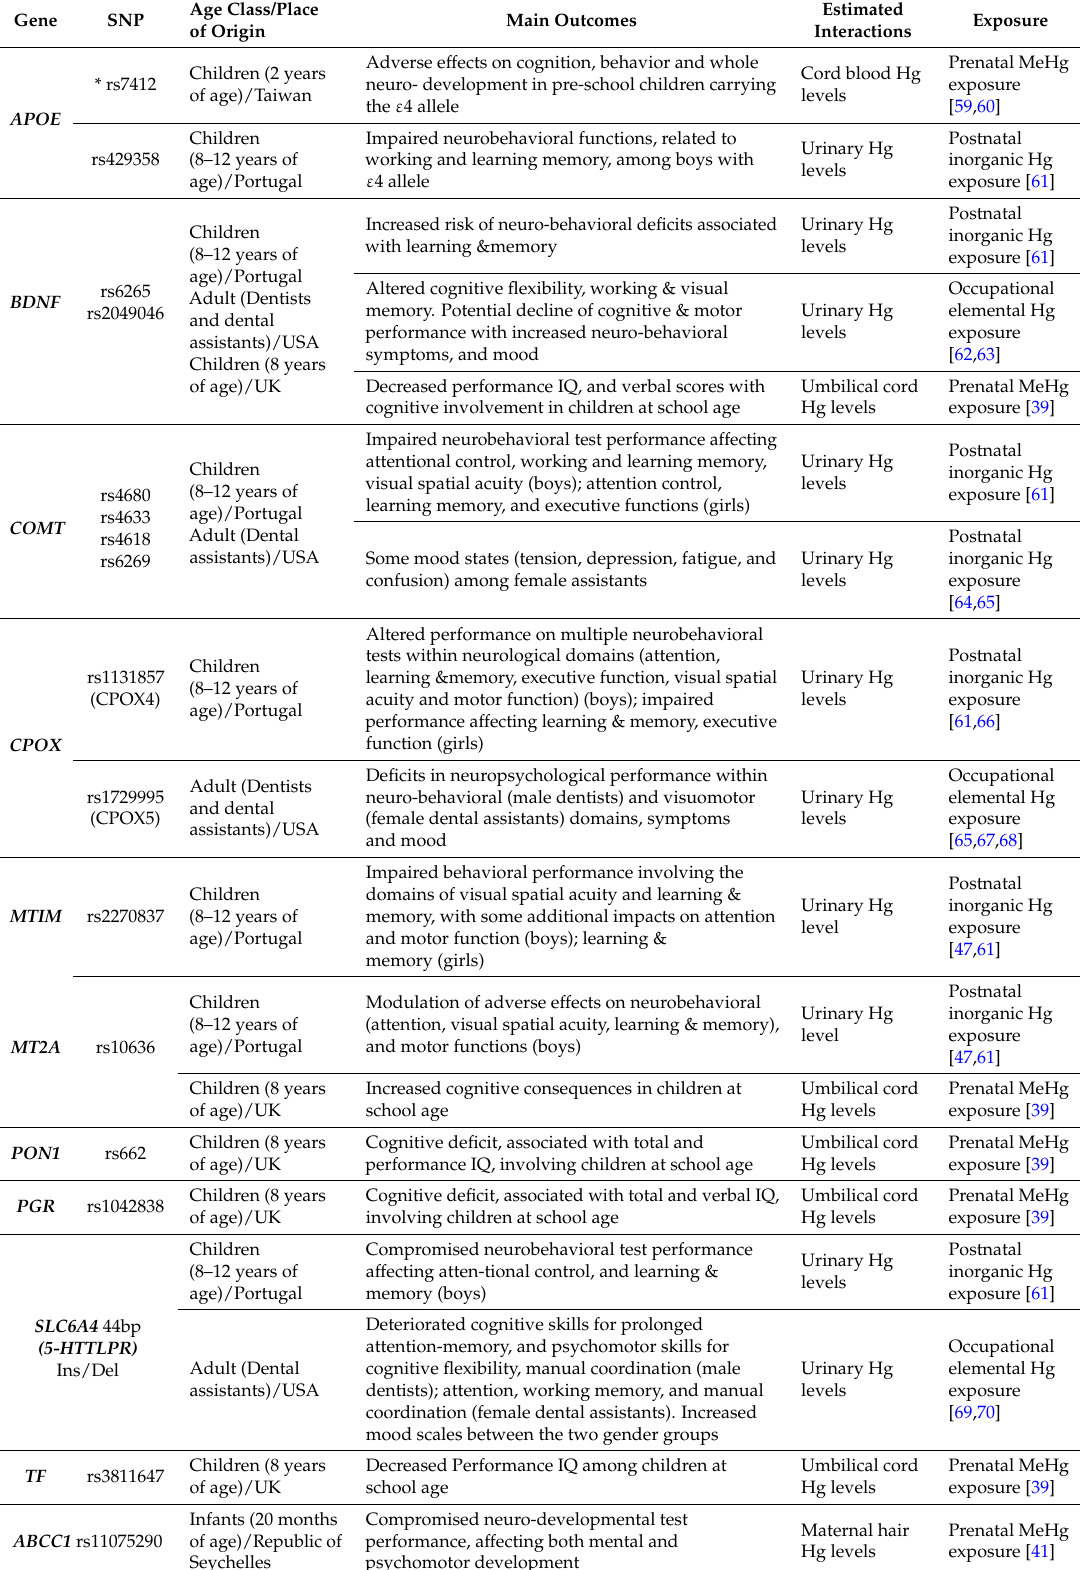
Table 3. Summary of main genetic variants related to mercury-induced neurotoxicity by association studies, with potential involvement for human